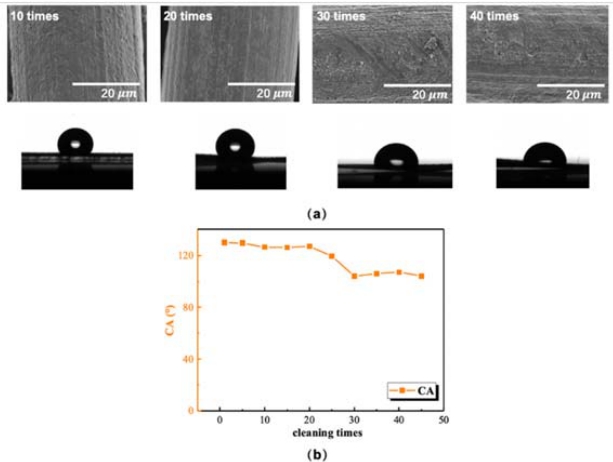
Figure 4. The properties of SPFO coating after several cleaning treatments. ( a ) The morphologies and oil contact angles of SPFO coatings after 10 to 40 cleaning treatments using cleaning agents. In SEM images, SPFO coating was prepared on stainless steel mesh to show wear on coating surface; ( b ) the oil contact angles of SPFO coating at different cleaning times.